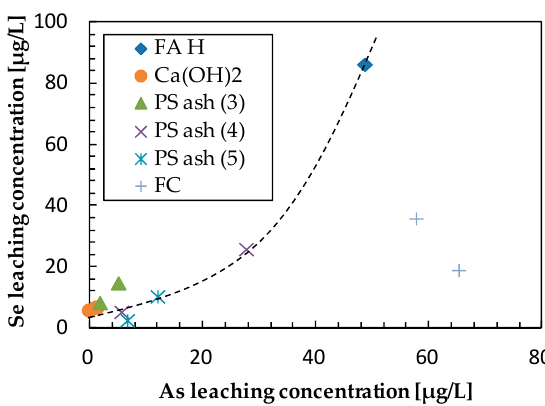
Figure 10. Relationship between the arsenic leaching concentration and the selenium leaching concentration.